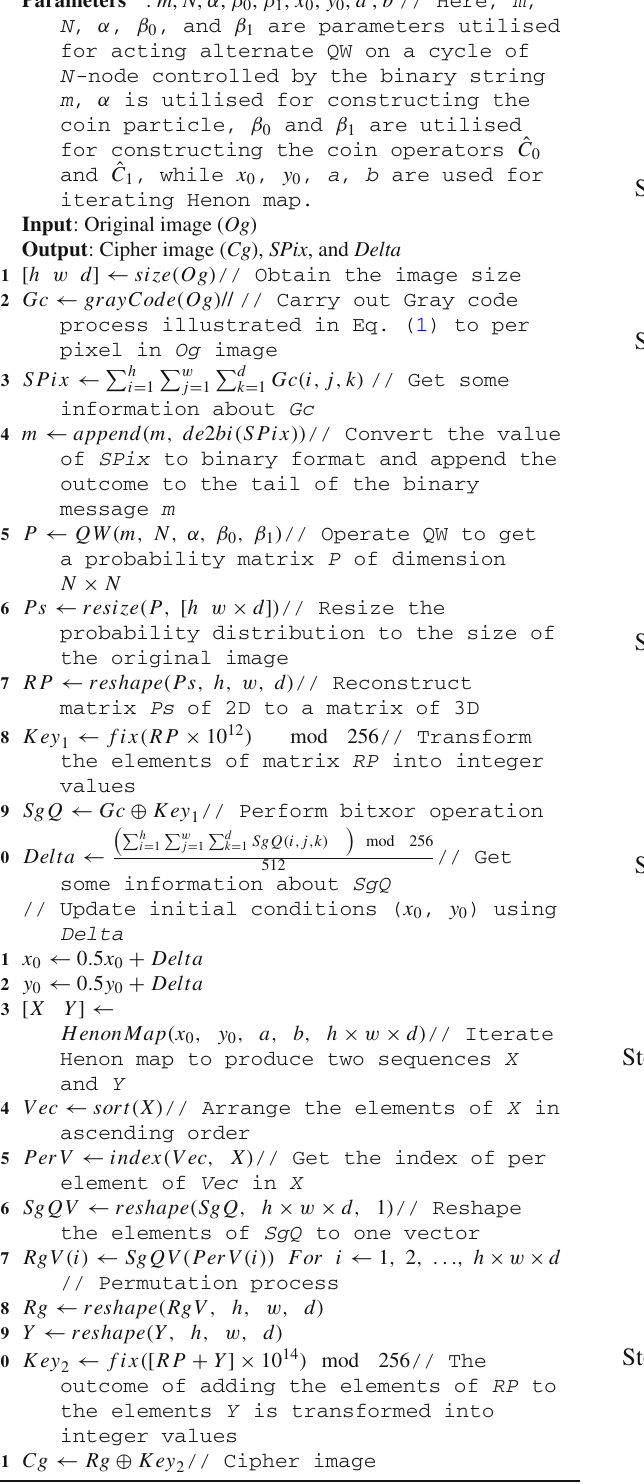
Algorithm 1: Encryption